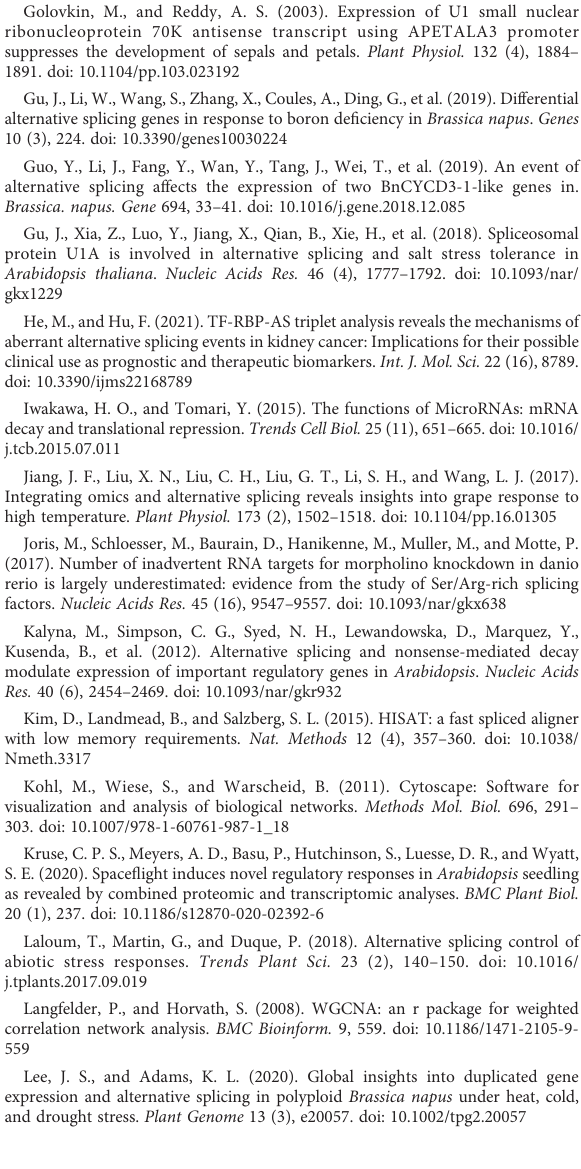
IncLevel value represented the normalized proportion of AS event. The red color denoted control and orange color denoted treatments. (D) displayed the structures of all transcripts of this gene. Red dashed box indicated exons and introns showed in sashimiplots corresponding to gene structures below. The blue rectangular boxes denoted the exons, the lines denoted the introns, and the arrows denoted the transcriptional direction. SUPPLEMENTARY FIGURE 5 The percentage of DAS genes overlapping with DEGs under each stress